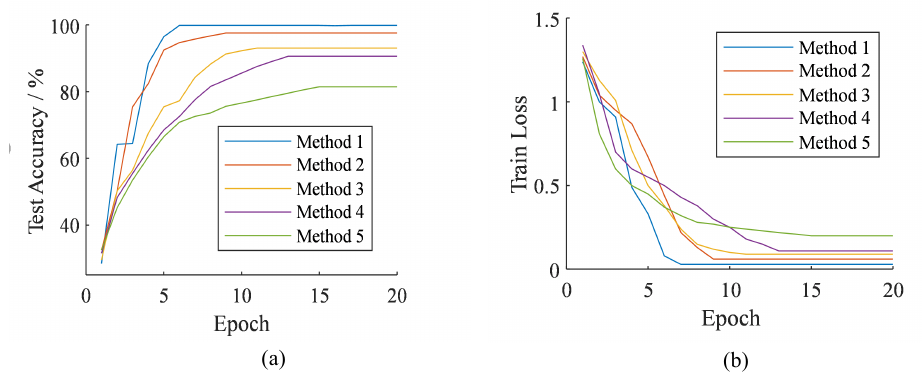
Figure 7. Training of different combination models: ( a ) curve of training set loss; ( b ) accuracy curve of the test set.